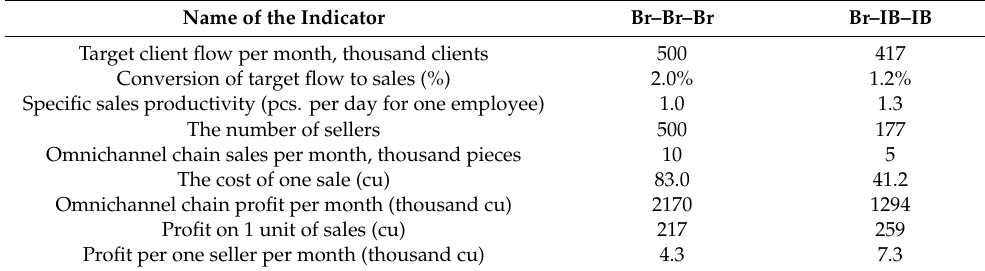
Table 5. Omnichannel sales chain scenario